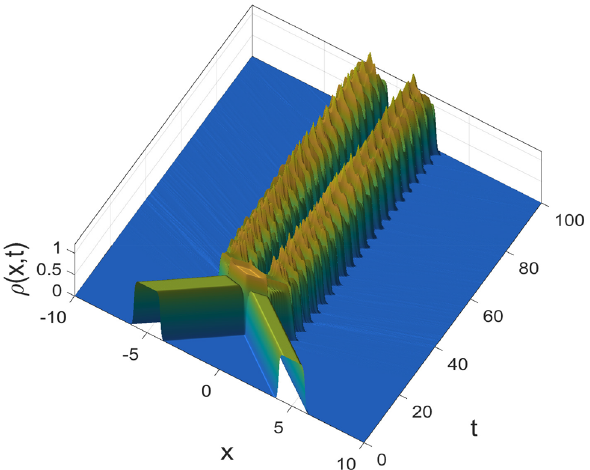
Fig. 10 Metastable structure formed by a pair compact-like defects viewed from the 3D plots of the energy